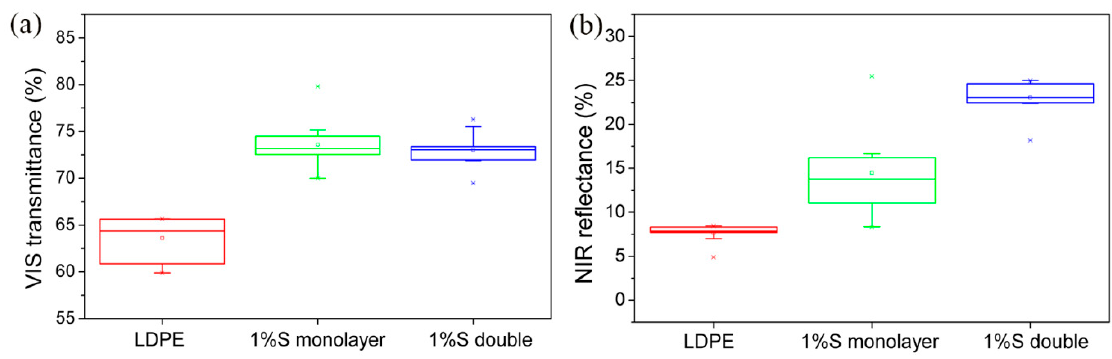
Figure 5. ( a ) A range of the visible radiation (VIS) transmittance of low-density-polyethylene (LDPE),